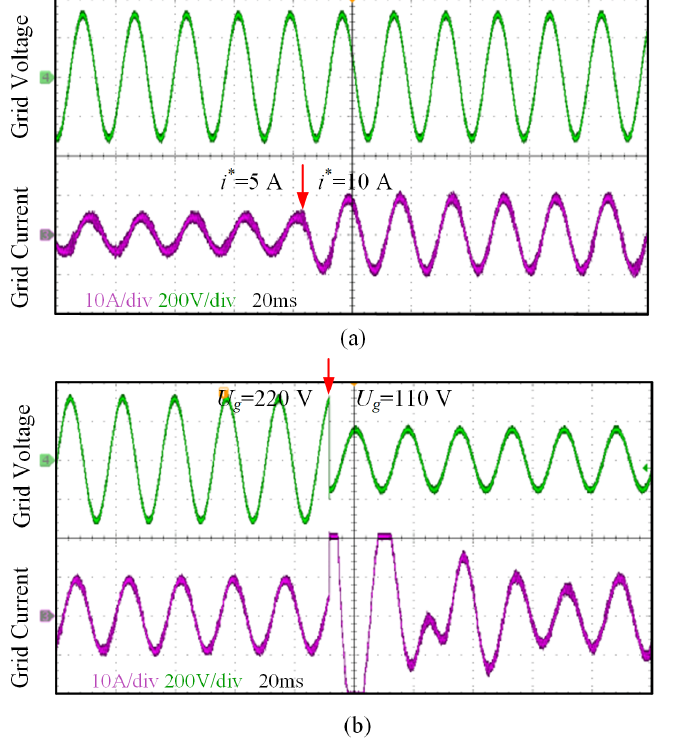
Figure 15. Waveform of the grid voltage and grid-connected current: ( a ) the current reference is changed from 5 A to 10 A; ( b ) the grid voltage dropped from 220 V to 110 V.